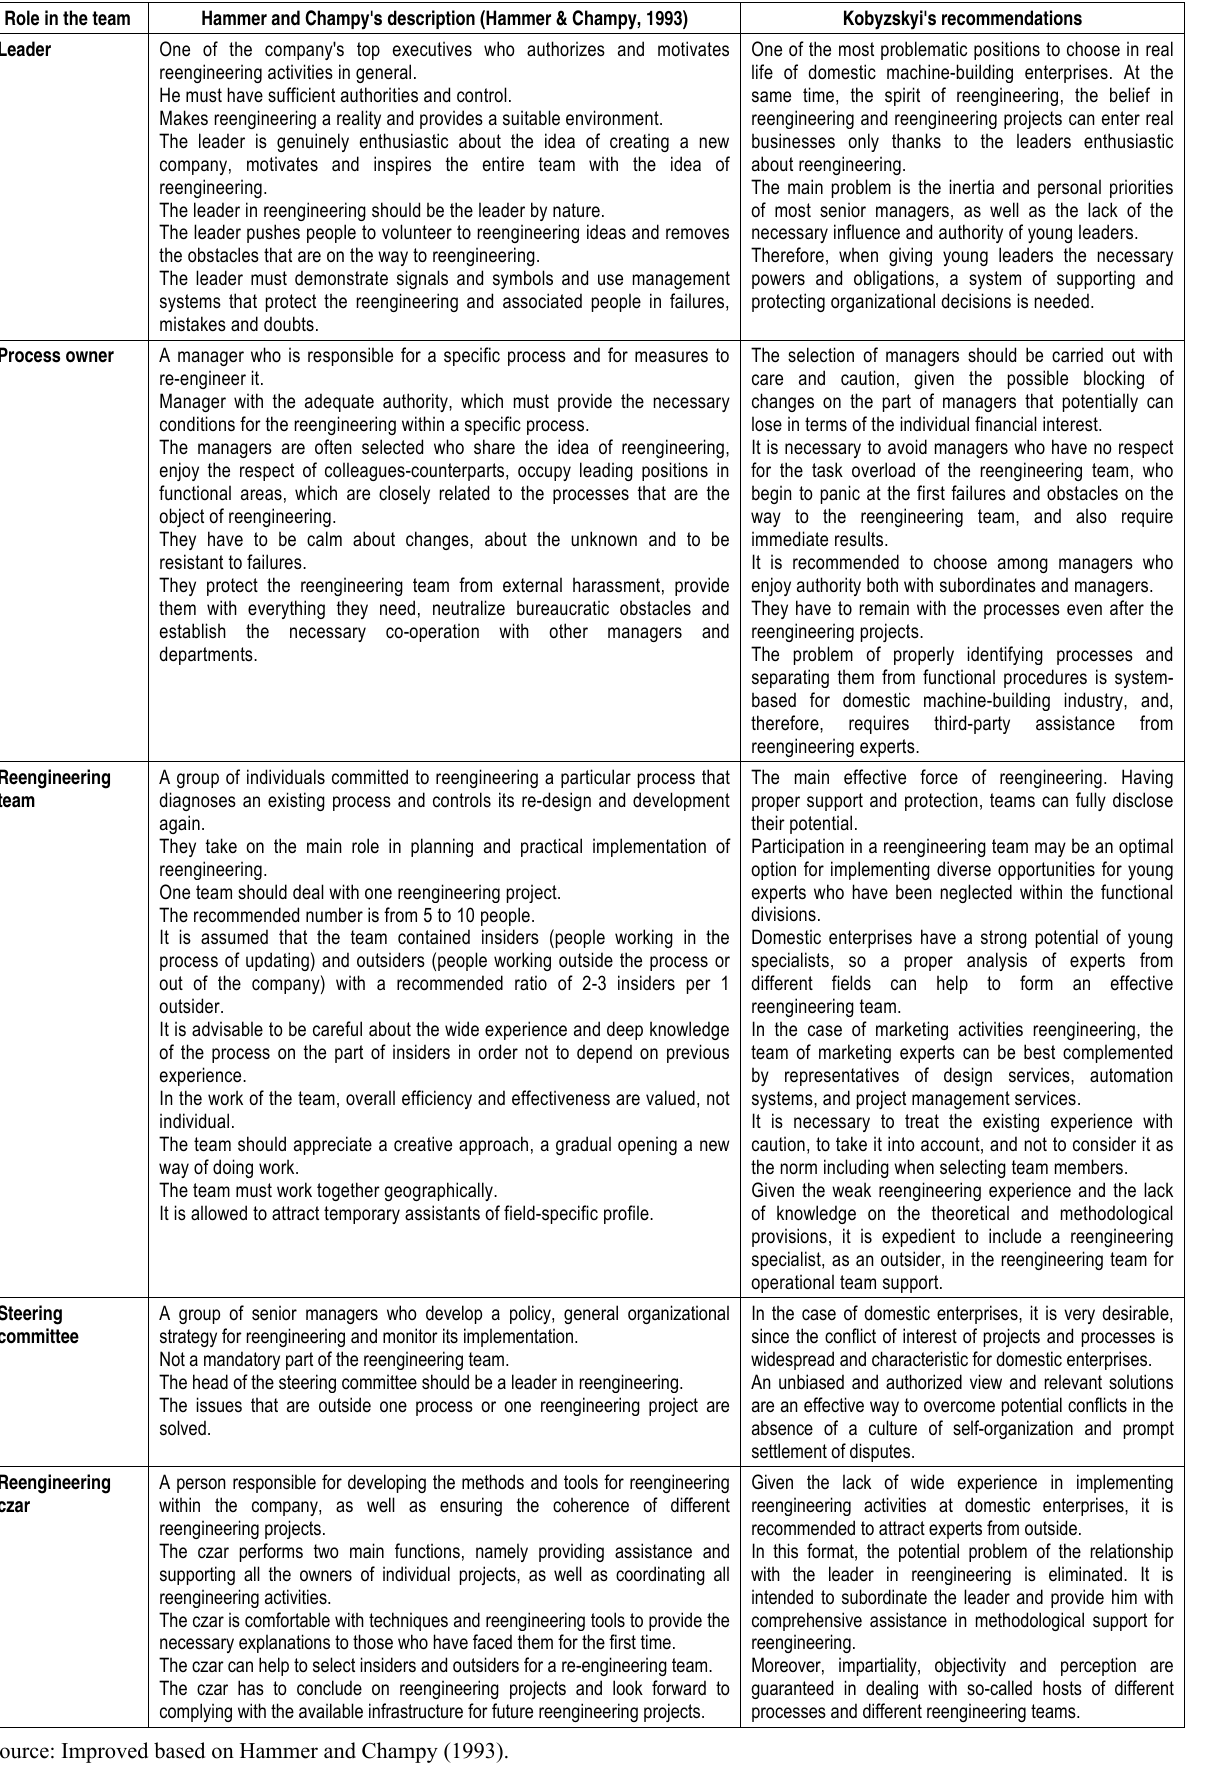
Table 2. Characteristics of effective persons in the reengineering team Role in the team Hammer and Champy's description (Hammer & Champy,